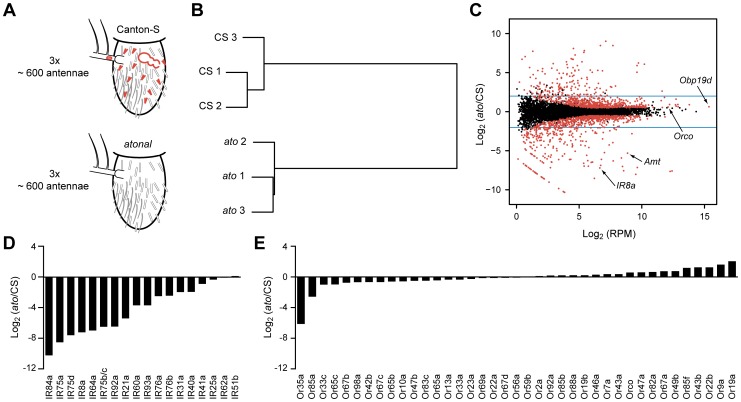
Transcriptome profiling identifies genes differentially expressed in CS and ato third antennal segments.(A) Schematic of the RNA-Seq screen in which three independent biological samples of third antennal segments from both CS and ato flies were collected. ato flies selectively lack coeloconic sensilla (small red hairs), aristal neurons (red oval in the arista, which extends to the left), and the multi-chambered sacculus (red bubble-like structure), which contains coeloconic sensilla. (B) Hierarchical cluster analysis of each sample based on their gene expression, showing that the expression patterns cluster by genotype. (C) Each of the antennal-expressed genes (dots) is plotted based on its average expression level in RPM and the log2 of the expression ratio between ato and CS flies. Most genes cluster around 0, indicating no change in expression. Red dots indicate differentially expressed genes (FDR <0.01), and the blue horizontal lines indicate a four-fold change level. Several genes of interest are indicated. The diagonal “line” of red dots in the bottom left consists of genes with no expression in ato (see Materials and Methods). (D) Nearly all of the IR genes are greatly reduced in ato antennae, consistent with their known localization to coeloconic sensilla. (E) In contrast, most of the Or genes expressed in CS antennae show little if any reduction in ato. We note that the fold-change values are approximate and are especially difficult to assess for genes that are expressed at extremely low levels in ato. (Figure S1). See Methods for further details.